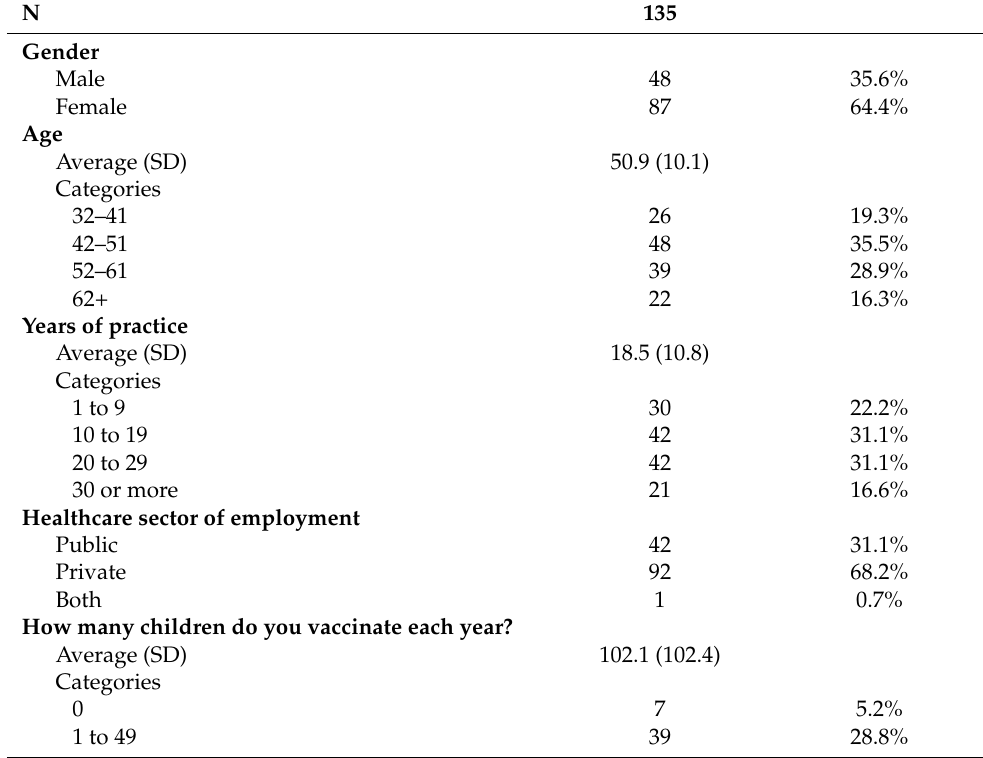
Table 5. Pediatricians’ sociodemographic